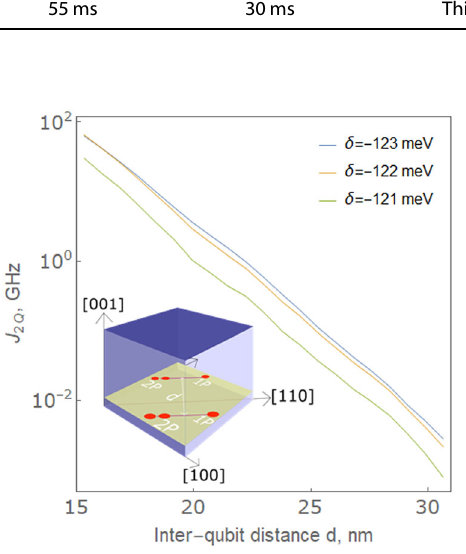
Fig. 5 Exchange energy ( J 2 Q ) vs.separation between qubits ( d ) for various bias voltages around the anti-crossing value. The two 2 P : 1 P multi-donor quantum dot qubits are oriented along [110] and considered for entanglement in head-to-tail position at an inter qubit distance d perpendicular to